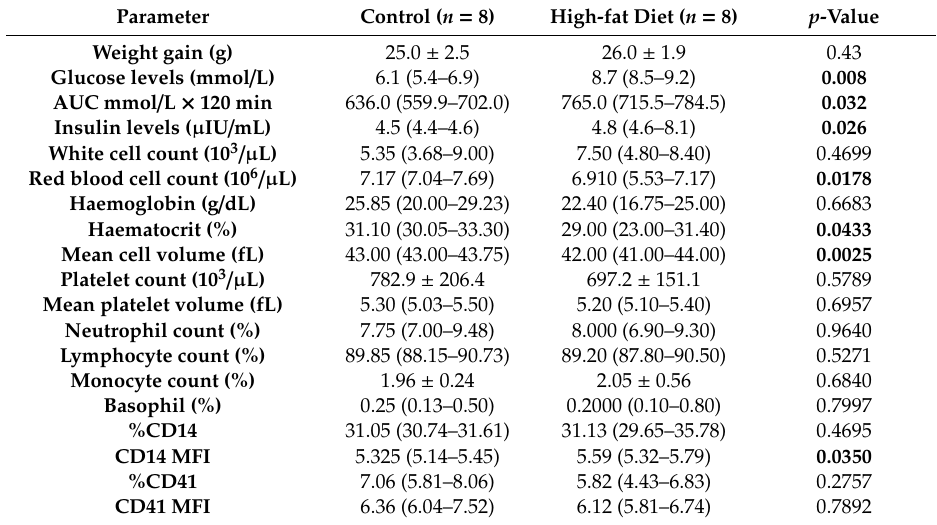
Table 2. An overview of metabolic and haematological parameters between high-fat diet-fed mice and controls.